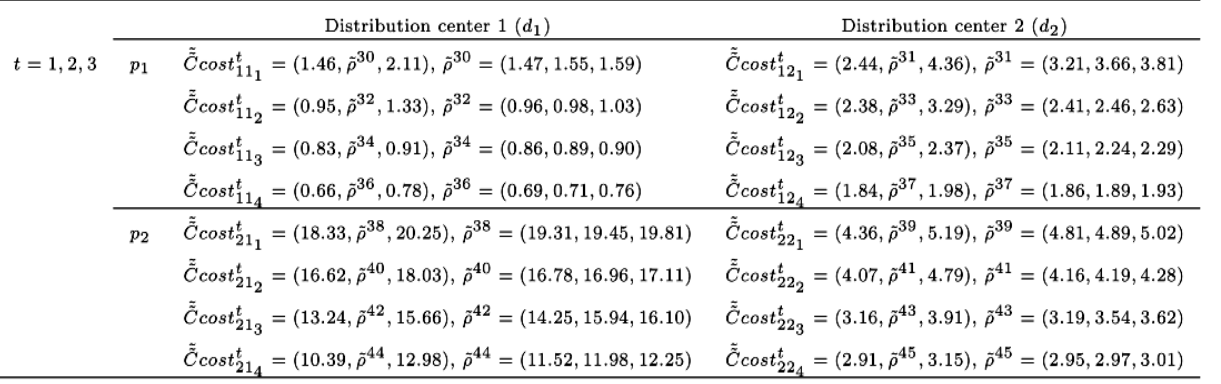
Table 4. Stock carrying cost